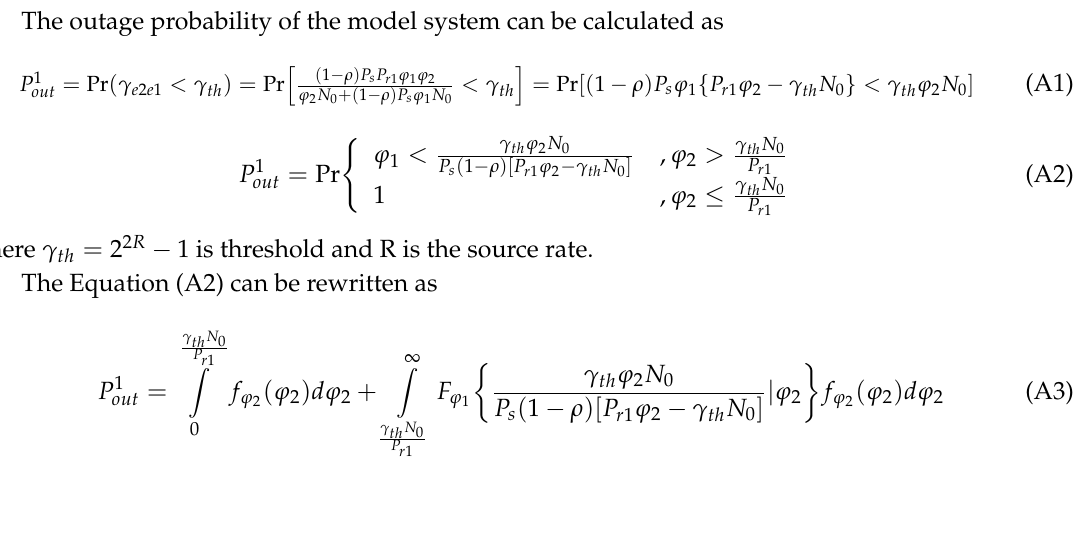
Figure 9. The exact and asymptotic SER versus P s / N 0 .